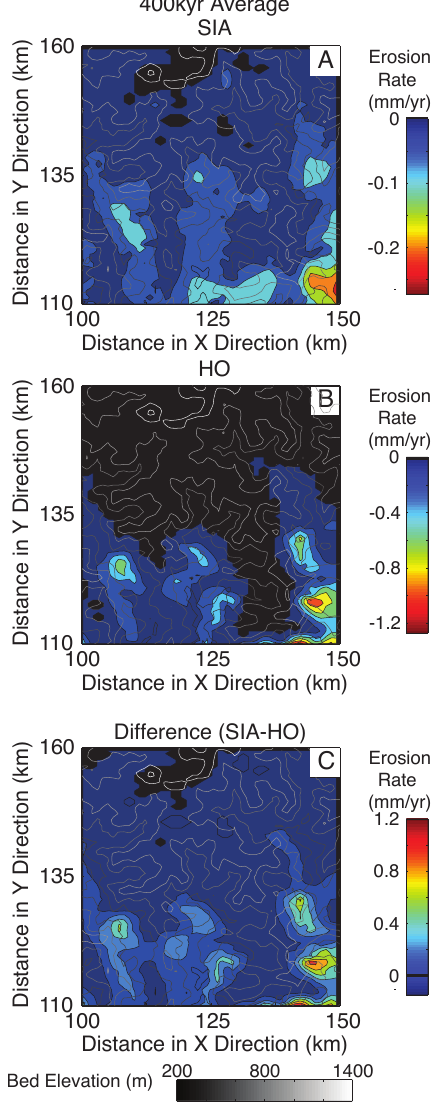
Figure 5. Pattern of erosion rates in nested region (Figs. 1 and 2) averaged over a single glaciation (grey-shaded areas in Figs. 3 and 4). The grey-scale topographic lines show the elevation of the underlying topography. (a) SIA erosion rates, where regions of no erosion are shown in white. (b) HO erosion rates, where regions of no erosion are shown in white. (c) Difference between the time- averaged erosion rates (SIA–HO).